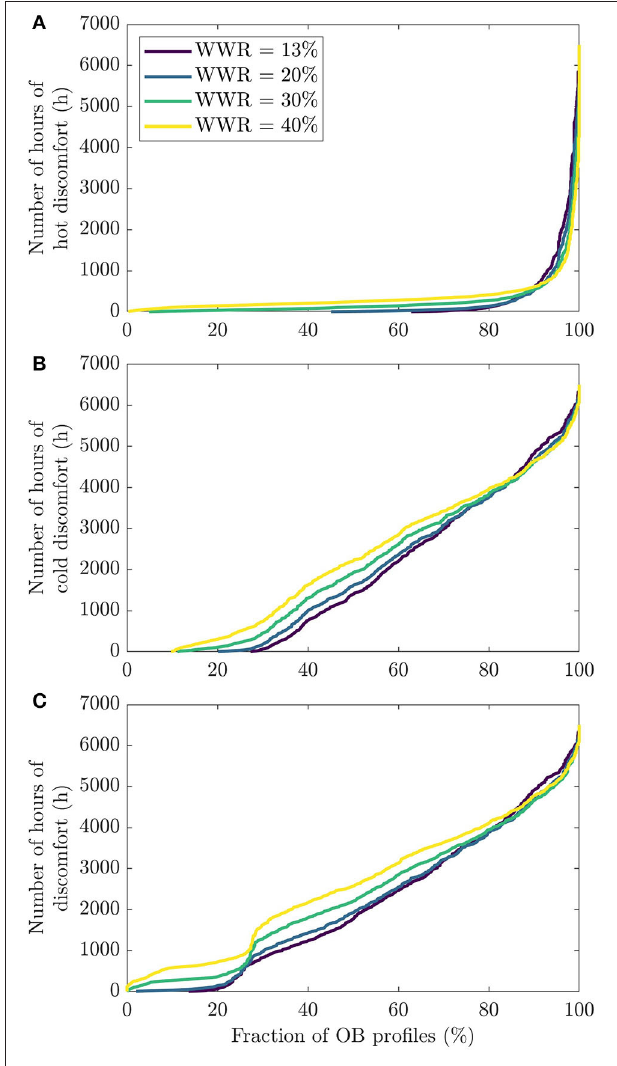
FIGURE 3 | Cumulative fraction of possible occupant behavior scenarios with a specific number of hours of (A) hot discomfort, (B) cold discomfort , and (C) total